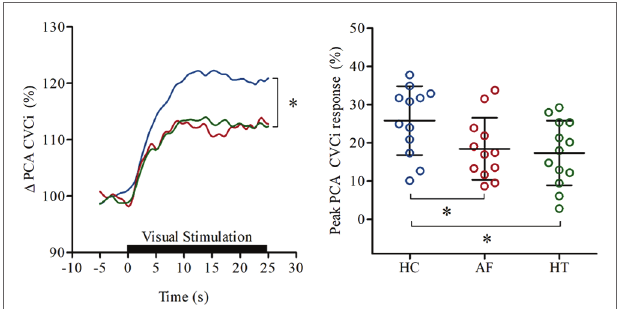
FIGURE 2 | Increase in PCA perfusion in response to neurovascular coupling observed in healthy controls (HC: blue), patients with atrial fibrillation (AF: red), and hypertension (HT: green). Lines on the left panel represent the mean responses; black bar indicates where eyes of the participants were open. Right panel shows the (%) peak posterior cerebral artery (PCA) conductance (CVC i ) responses of individuals. Horizontal bars show mean and SD values for each group. * p < 0.05 vs. HC. Modified from Junejo et al. (2019a; open access article published under CC-BY 4.0